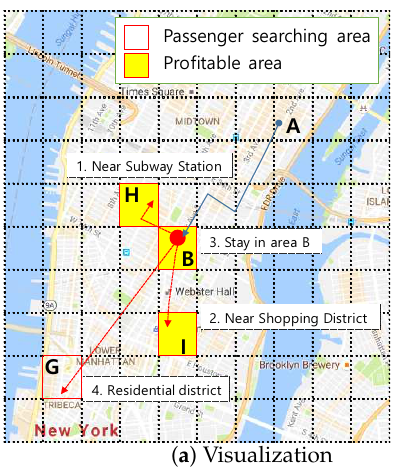
Figure 1. Finding profitable